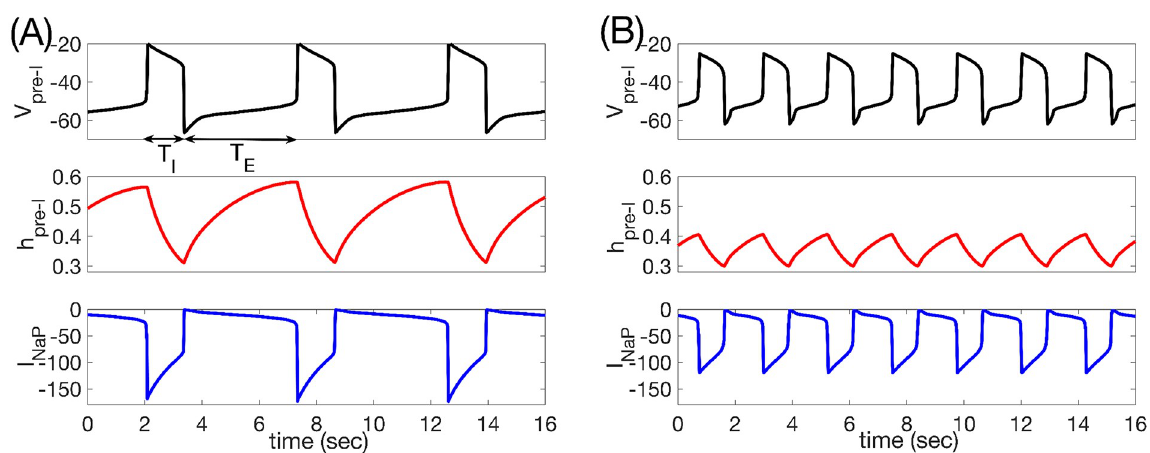
Fig 11. Pre-I dynamics varies across inhibition levels. (A) Baseline levels of inhibition to the preBo¨tC yield relatively long respiratory periods deinactivation (red) and total magnitude (blue). (B) Inhibition at 50% with large amplitude pre-I voltage excursions (black) and significant I NaP of baseline yields a faster period due to shortening of T I and, especially, T E , with less deinactivation and total magnitude of I NaP